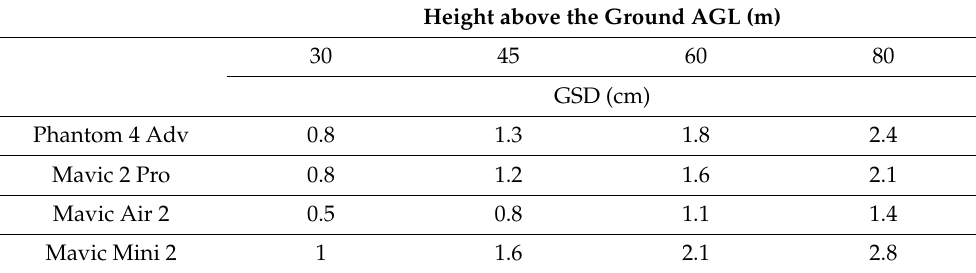
Table 2. UAS’ performed flight missions for different AGLs.